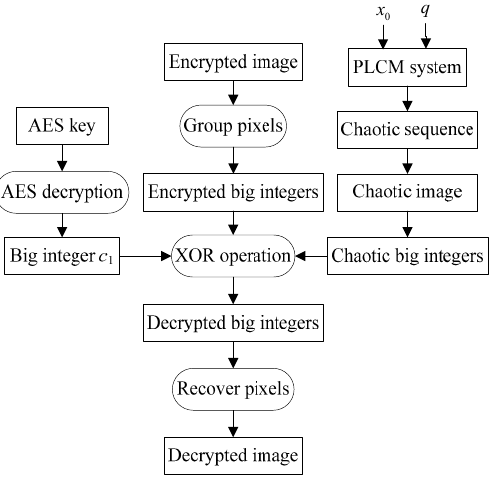
Figure 3. The decryption flowchart of the proposed algorithm.